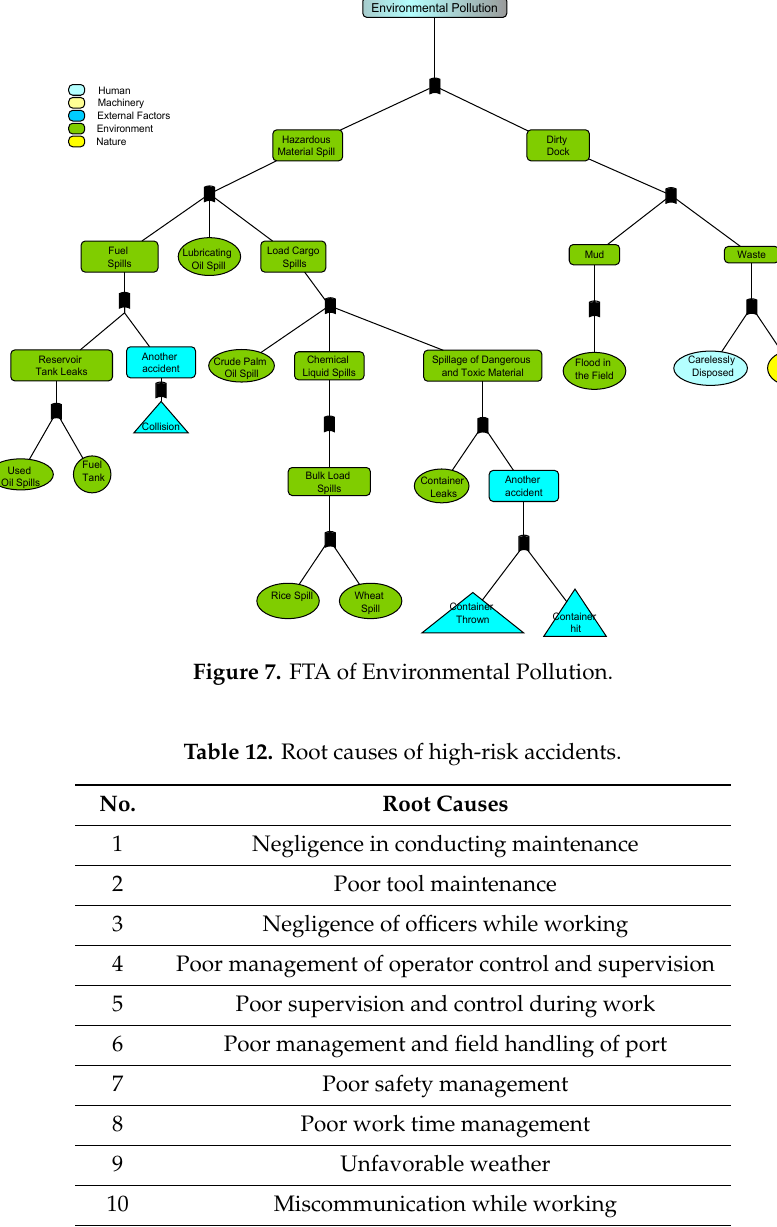
Table 12. Root causes of high-risk accidents.